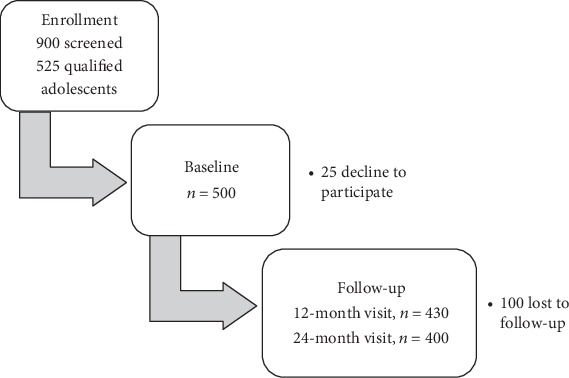
ROBIM study overview.